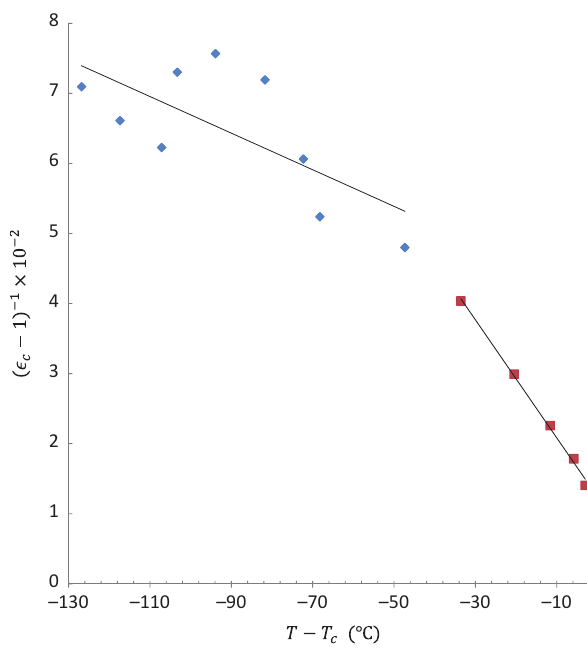
Figure 2: The reciprocal dielectric constant ε c as a function of T − T c in the ferroelectric ( T < T c ) phase of TMAHSO 4 in the two temperature intervals indicated. Solid line represents the fit of eq. (15) to the observed data [1] (See Table 2).